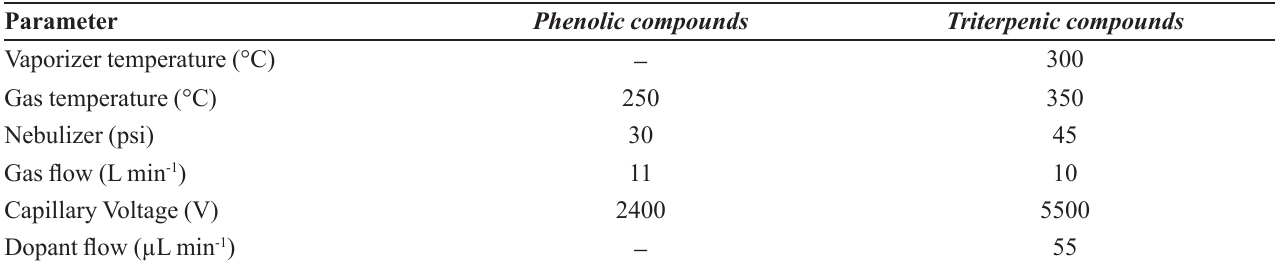
TABLE I - Parameters and conditions of the UHPLC-MS/MS analysis of phenolic and triterpenic compounds